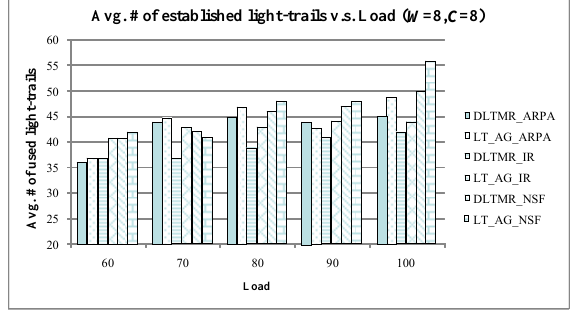
Fig. 12. The average number of established light-trails versus